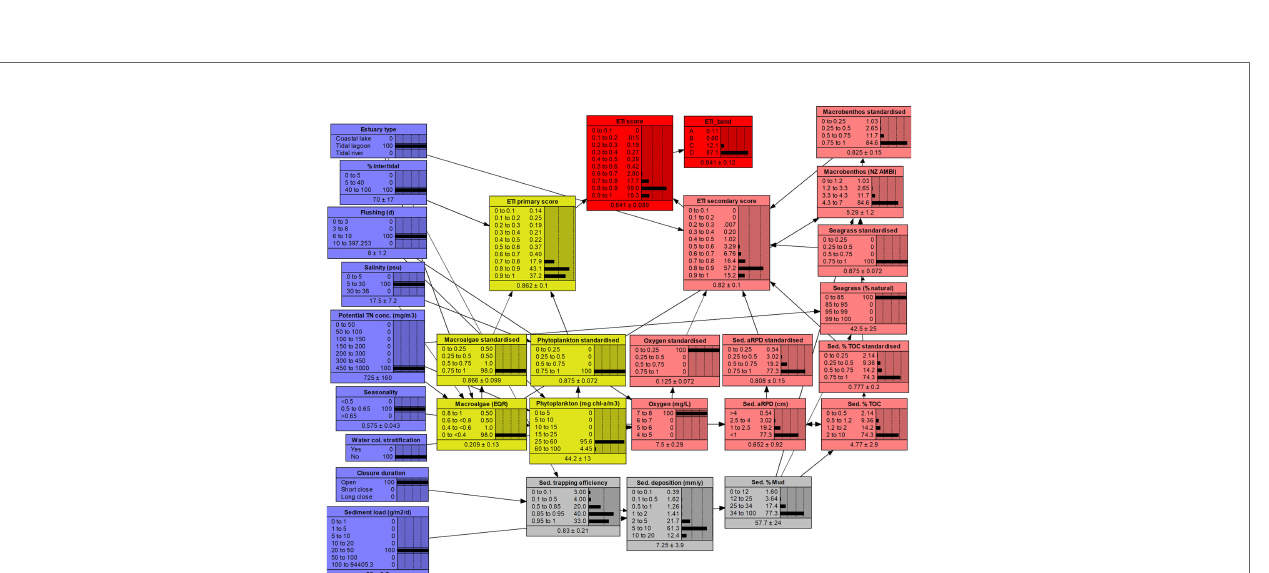
FIGURE 3 | ETI Tool 3 BBN NETICA structure. Blue boxes are driver nodes with values input from ETI Tool 1, yellow and pink nodes are primary and secondary indicator nodes and the red nodes are the fi nal ETI score and bands. Grey nodes are intermediate calculation nodes. Indicator nodes have accompanying standardising nodes that normalise their respective scores prior to input to the primary and secondary scoring nodes. This BBN run shows results for Jacob River Estuary (Southland region, NZ) in its present